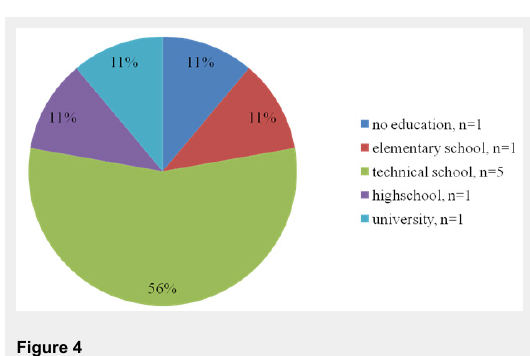
Knowledge of BAG/BASPO recommendation. Nine (38%) of the 24 patients knew about the BAG/BASPO recommendation: one (11%) patient was a graduate of an elementary school, 5 patients (56%) of a technical school, one patient (11%) of high school, one patient (11%) of the university and one (11%) patient had no educational